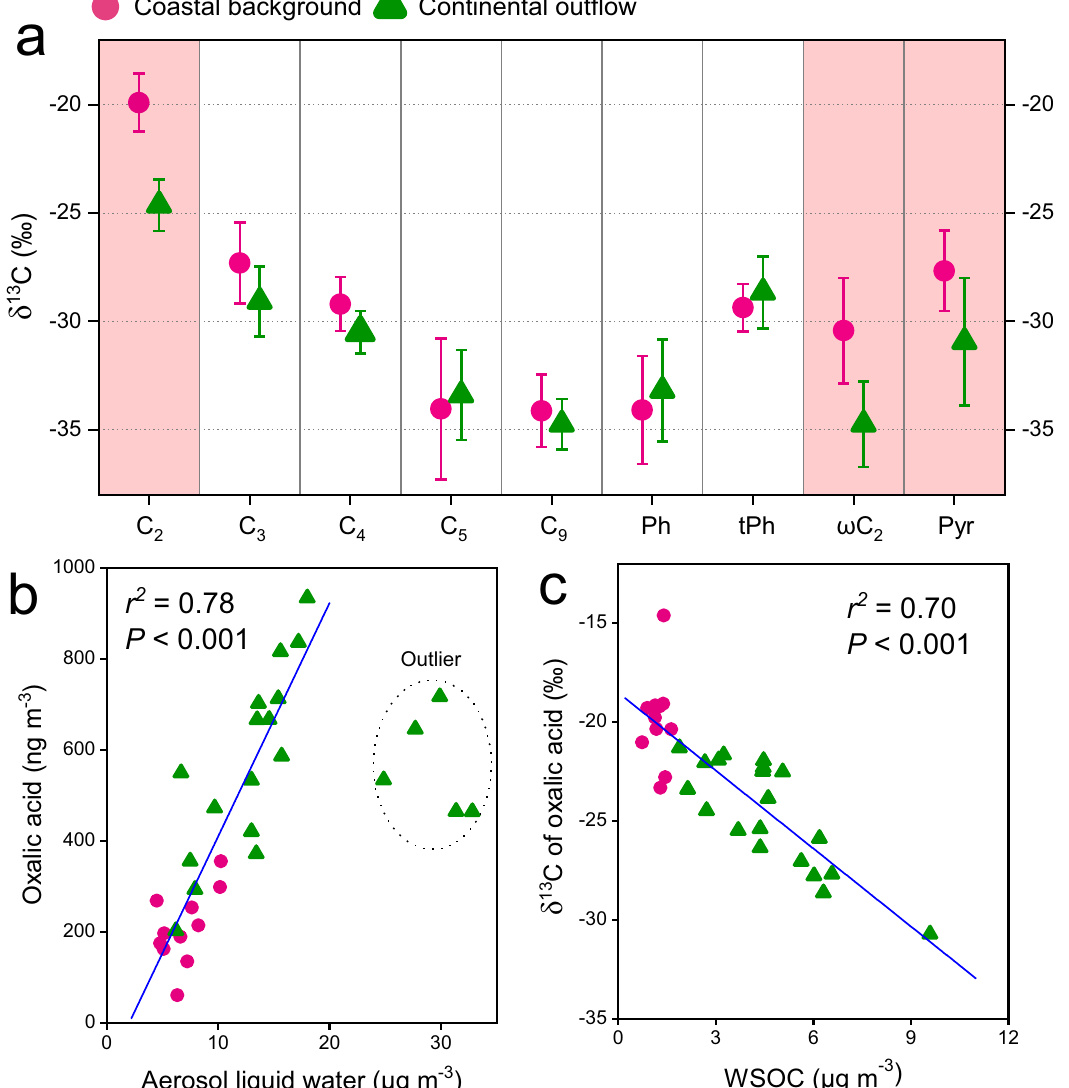
Fig. 3 | Stable carbon isotopic evidence of aqueous secondary organic aerosol (aqSOA)formation.a Average δ 13 Cvaluesofsaturatedaliphaticdicarboxylicacids (C 2 − C 9 ),aromaticdicarboxylicacids[phthalicacid(Ph)andterephthalicacid(tPh)], andoxocarboxylicacids[glyoxylicacid( ω C 2 )andpyruvicacid(Pyr)]forthetwoair mass regimes. The error bars indicate the 95% con fi dence interval of δ 13 C values in